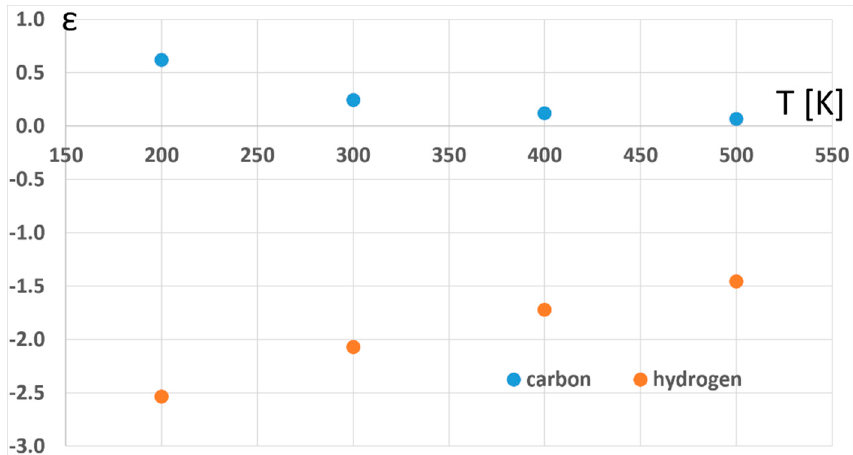
Figure 4. The temperature dependence of the calculated isotopic fractionations.